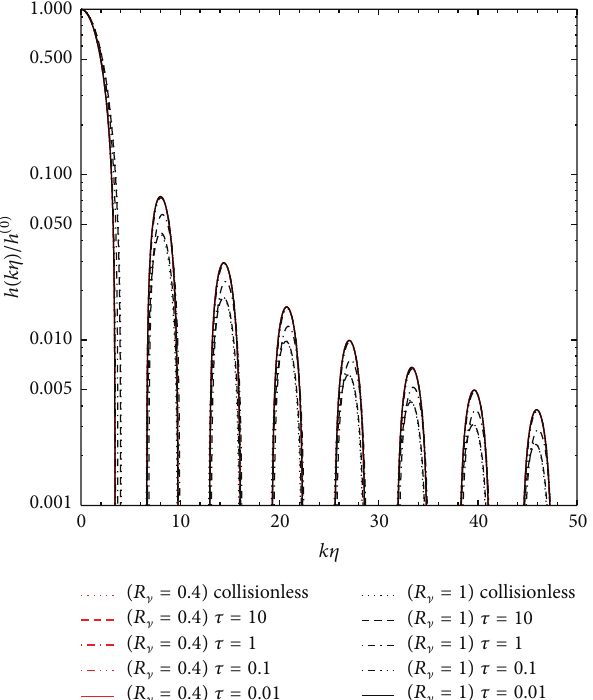
Figure 8: Evolution of the normalized wave amplitude ℎ 𝑖𝑗 /ℎ (0) 𝑖𝑗 as function of 𝑘𝜂 for the RMD scenario in case of including the collision term, in correspondence with Figure 3, with RMD curves being correctly interpreted by observing that 𝑘𝜂